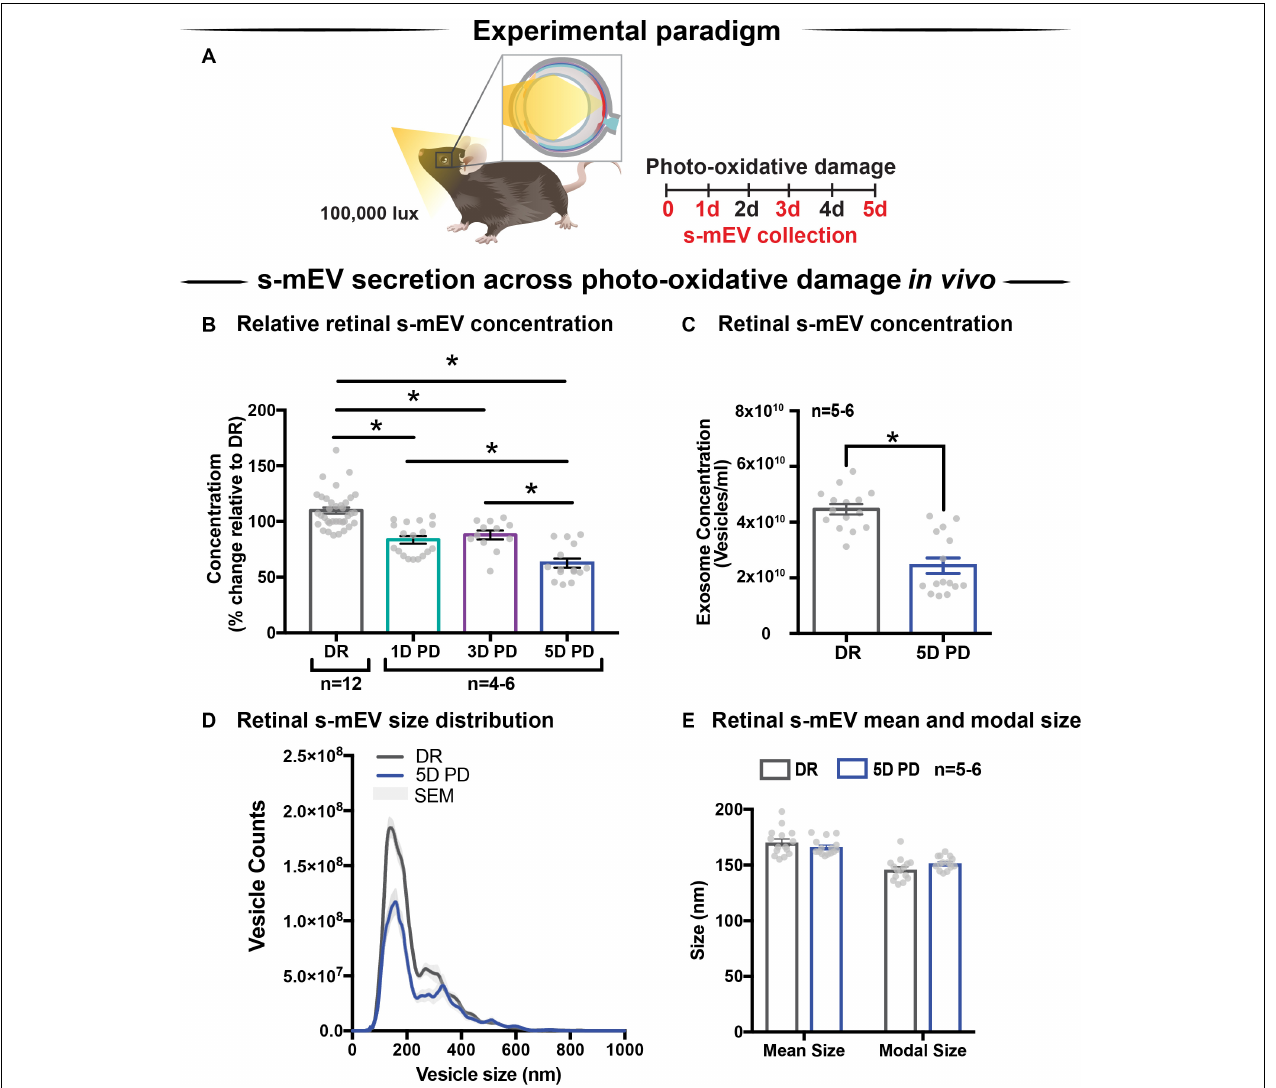
FIGURE 2 | Retinal s-mEV decrease in concentration but not size, over photo-oxidative damage-induced degeneration. (A) Experimental paradigm, with red retinal labeling indicating lesion site. (B) Concentration of retinal s-mEV decreased progressively across time in PD, with significantly reduced s-mEV at 1D, 3D, and 5D PD compared to DR controls ( P < 0.05, n = 3–12). Concentration values are presented as percentage of DR. (C) Significant reduction in the concentration of s-mEV from 5D PD retinas compared to DR controls ( P < 0.05, n = 5–6). (D) No significant change in the size distribution of s-mEV isolated from 5D PD retinas compared to DR controls, however vesicles with size < 200 nm show a marked decrease in concentration following 5D PD ( P > 0.05, n = 5–6). (E) No difference in either the mean or modal size of retinal s-mEV between DR and 5D PD groups ( P > 0.05, n = 5–6). All results obtained using nanotracking analysis (NanoSight NS300). * denotes = P <